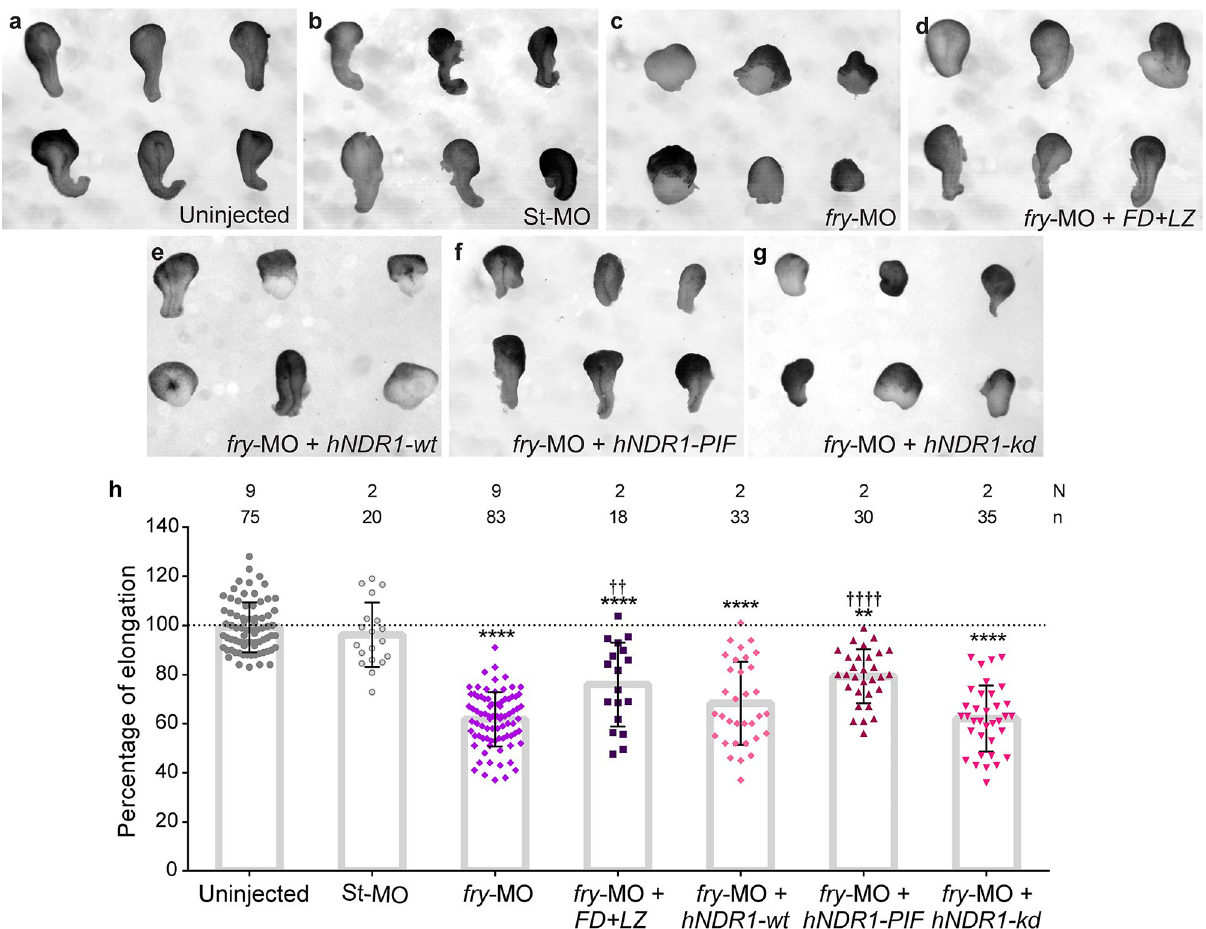
Figure 8. Loss of Fry impairs convergent extension movements and can be compensated by constitutively active hNDR1-PIF kinase . ( a – g ) Dorsal marginal zone explants were prepared from Xenopus embryos at early gastrula stage (St. 10.5) and culture until late neurula stage (St. 19) when the elongation of the explant was evaluated. ( a ) Uninjected embryos. ( b ) Standard Control morpholino (St-MO) (15 ng) injected embryos. ( c ) fry -MO (15 ng) injected embryos and ( d ) fry -MO (15 ng) + FD + LZ mRNA (800 pg) co-injected embryos. ( e ) fry -MO (15 ng) + hNDR1-wt mRNA (250 pg) co-injected embryos ( f ) fry -MO (15 ng) + hNDR1-PIF mRNA (250 pg) co-injected embryos and ( g ) fry -MO (15 ng) + hNDR1-kd mRNA (250 pg) co-injected embryos. Representative explants are shown. ( h ) Percentage of elongation of dorsal marginal zone explants from embryos treated as indicated. Elongation was calculated as the difference between the initial and final length of the explants (St. 10.5 vs. St. 19) relative to the mean of the uninjected group (considered 100% elongation, dotted line). Each point represents a single explant. N: number of independent experiments, n: number of explants. Statistical significance was evaluated using Kruskal–Wallis test and Dunn’s multiple comparisons test (****, †††† p < 0.0001 and **, †† p < 0.01). * represents the comparison to the uninjected group and † represents the comparison to the fry -MO injected convergent thickening still operates in the absence of Fry. Additionally, our cell tracking recordings of fry - depleted embryos reveal alterations in the movement of superficial IMZ cells and the spatial organization of the cells near the blastopore lip, revealing a lack of coordination between the forces that operate in the system. The fibronectin component of the ECM plays a critical role in the regulation and maintenance of gastrulation movements and blastopore closure 48 . Fibronectin in the cleft of Brachet provides physical support for mesendo- derm cell migration 43,57,58 , as well as a source of signaling 59,60 . Loss of fibronectin can lead to alterations in the migratory kinetics of leading-edge mesodermal cells 48 and therefore might also contribute to the abnormal devel- opment of anterior structures in fry -depleted embryos 29,61 . As in fibronectin knock-down embryos, convergent extension is disrupted in fry -depleted embryos. However, DMZ cells lacking Fry fail to elongate and orient when provided an exogenously fibronectin substrate, suggesting the existence of an additional mechanism affecting the morphogenetic behavior of these cells. Based on these migratory defects and loss of cell polarization and orientation, it is possible that Fry regulates cytoskeleton dynamics. In Drosophila, Fry has been found to alter actin organization during egg chamber elongation and hair wing morphogenesis, as well as to regulate microtu- bule sliding in neurons 13,15,62 . Given that Fry binds to microtubules and regulates their dynamics in Drosophila and mammalian cells 21–23 , controlling chromosome alignment, mitotic spindle orientation and morphogenesis,